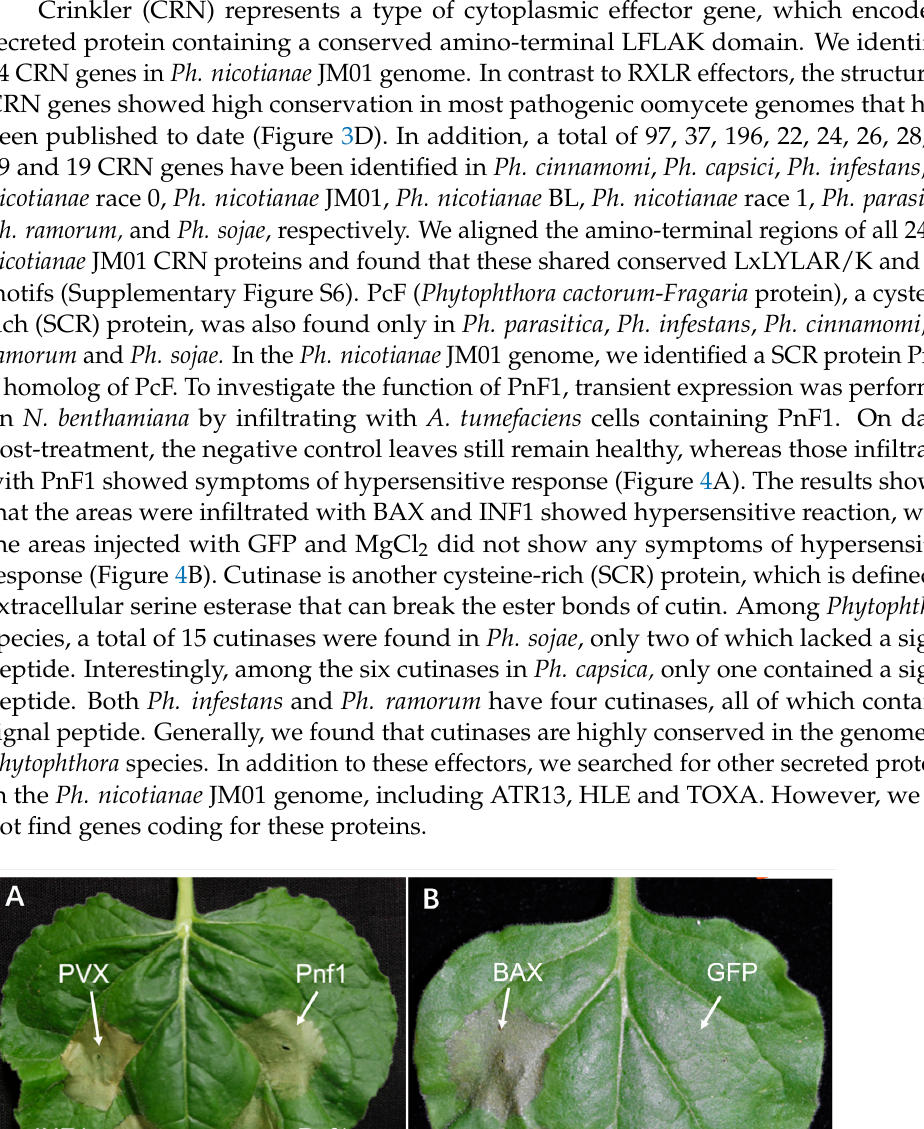
Figure 3. Prediction results of effectors in Ph. nicotianae JM01 genome and other species. ( A ) Results of effectors in the Ph.nicotianae JM01 genome and other species. A heatmap was used to present the gene numbers of RXLR, PCF and ELICITIN; ( B ) Genes structures of RXLR in Ph.nicotianae JM01. Conserved domains were drawn in NCBI; ( C ) Typical architecture of RXLR in Ph. nicotianae JM01; ( D ) Typical architecture of CRN in Ph. nicotianae JM01.